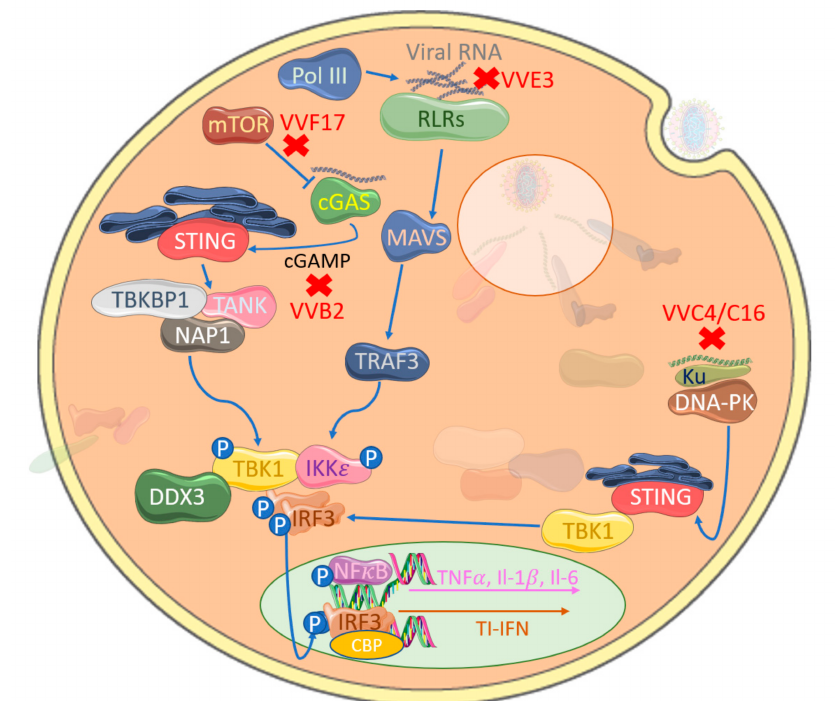
Figure 4. Poxviral inhibition of cytosolic nucleic acid sensing leading to IRF activation. VACV-encoded E3 (VVE3) binds dsDNA acting as a competitive inhibitor of RLR activation. Similarly, VACV-encoded C4 and C16 (VVC4 / C16) inhibit DNA binding to Ku, therefore blocking DNA-PK-mediated stimulator of interferon genes (STING) activation and, hence, TBK1 activation. The VACV-encoded poxin B2 (VVB2) hydrolyses the 3 (cid:48) − 5 (cid:48) bond on cGAMP, thus inactivating this key messenger molecule in cGAS-STING activation. A further target is mTOR-dependent cGAS degradation by VACV-encoded F17 (VVF17), thus suppressing cGAS-mediated TI-IFN gene